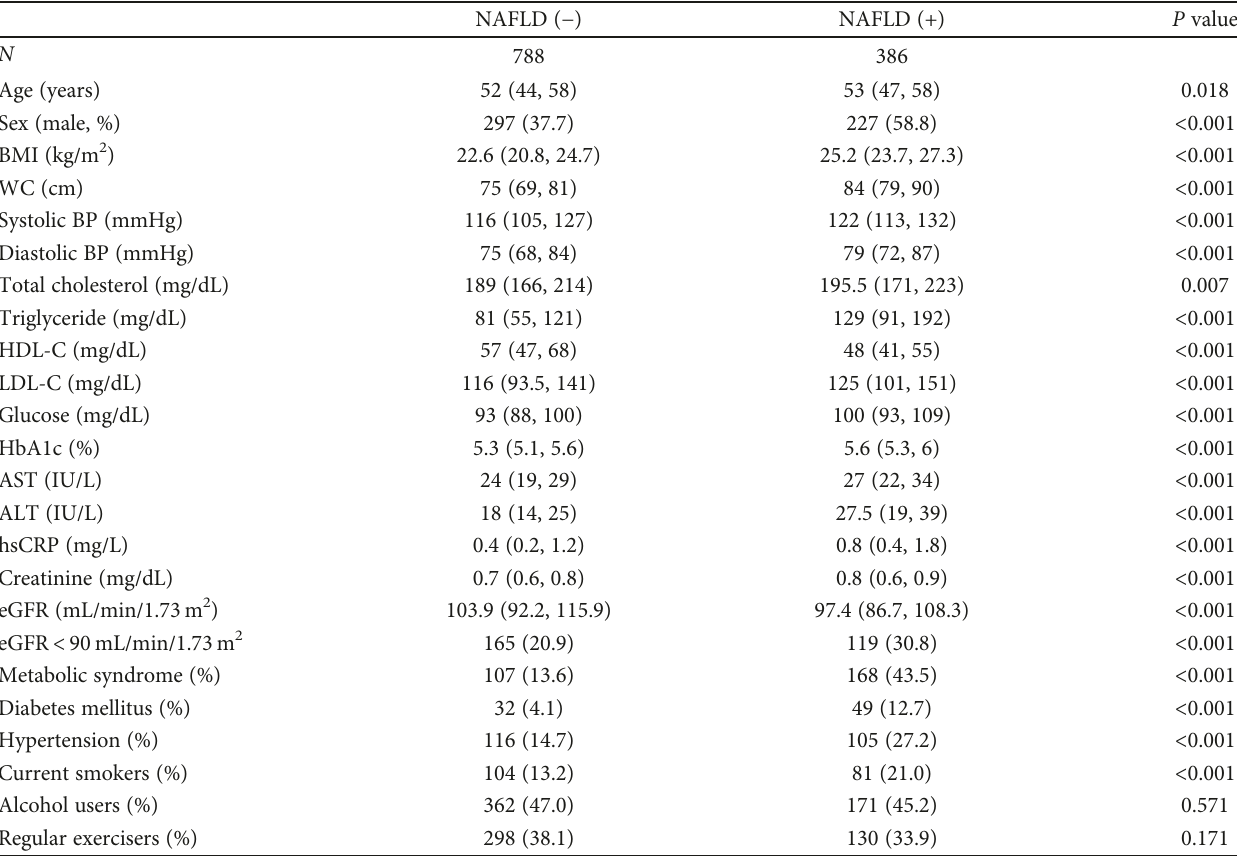
Table 1: Characteristics of study